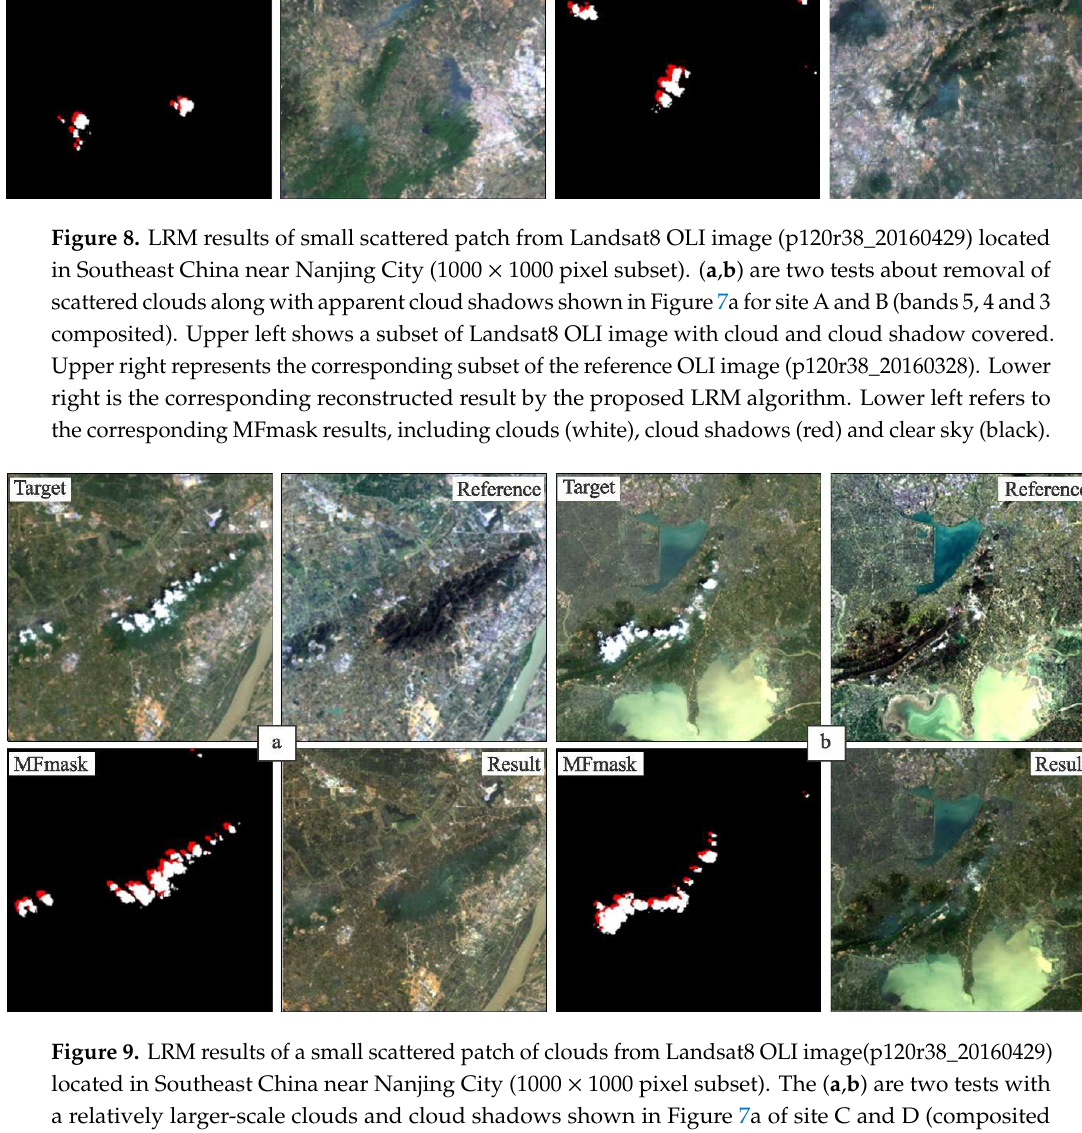
consistency with the neighboring original pixels. Thus, the proposed LRM method can also be used in the relatively large-scale thick cloud removal. We also compared the LRM reconstructed result of RGB bands (bands 4, 3 and 2) and the NIR band (band 5) in Figure 10 for the site E in Figure 7a. The cloud removal image in Figure 10a (bands 4, 3 and 2, composited) and Figure 10b (bands 5, 4 and 3 composited) both show good radiometric consistency, indicating high accuracy in DN value estimation by the LRM method for all four bands including NIR band 5.